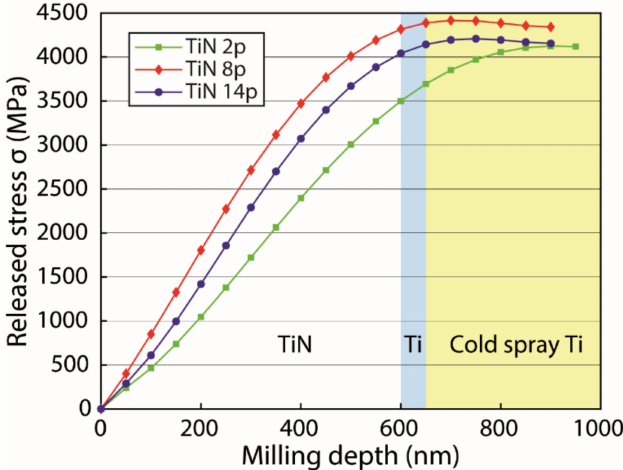
Figure 13. The residual stress result of TiN/Ti duplex coating: TiN 2p, TiN 8p, and TiN